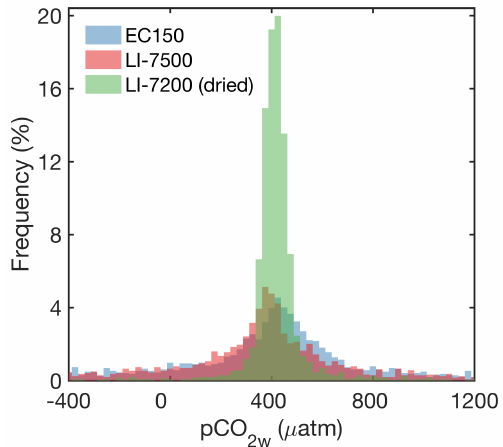
Figure 12. Gas transfer velocity ( k 660 ) plotted against 10m neu- tral wind speed for three periods in which the RV Martin Bergmann measured p CO 2w within 3km of the tower and in which the magni- tude of (cid:49)p CO 2 (i.e., p CO 2w − p CO 2atm ) was greater than 20µatm. Parameterizations of Wanninkhof (1992) and Wanninkhof (2014) are shown as blue and red lines, respectively.